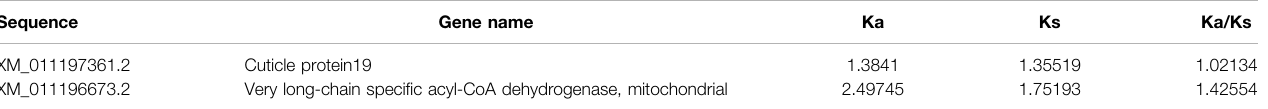
TABLE 2 | Strong positive select genes of Zeugodacus cucurbitae (Coquillett) and Bactrocera dorsalis (Hendel).